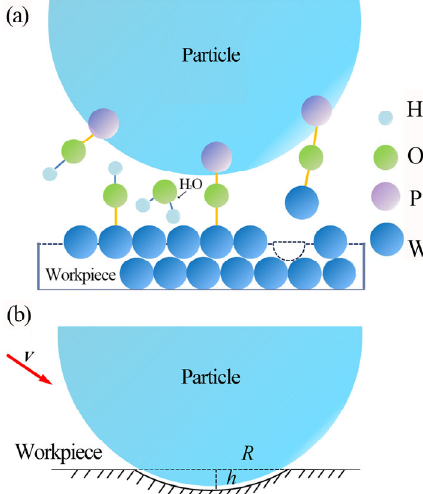
Fig. 6 Schematic illustrations of the material removal induced by the particle  surface collision. (a) Adsorption removal model in which P–O–W bonds are formed in between the particle and the workpiece accompanied by the release of water molecules, where P represents the atom of the particle, O the oxygen atom, and W the atom of the workpiece. (b) Bombardment removal